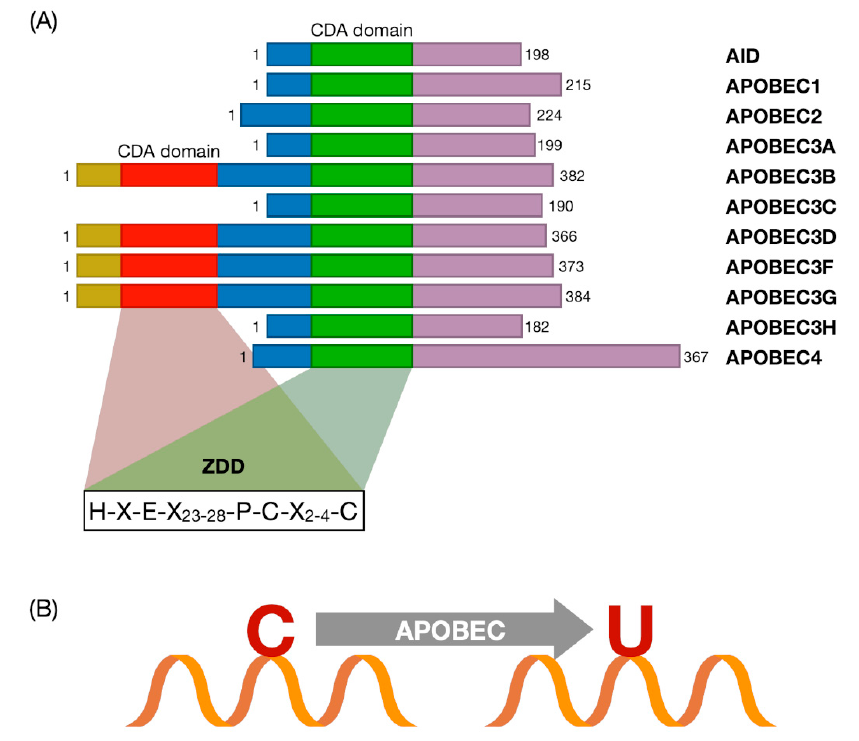
Figure 1. ( A ) Schematic representation of the apolipoprotein B mRNA editing enzyme catalytic polypeptide-like (APO- BEC) family genes. The diagram shows the structural organization of APOBEC family proteins. The domains and position of the evolutionarily conserved residues are shown. The red box represents the catalytically inactive cytidine deaminase (CDA) domain, while the green box is the catalytically active CDA domain. The zinc-dependent deaminase (ZDD) con- sensus amino acid sequence (H-X-E-X23-28-P-C-X2-4-C) is shown. X represents any amino acid. Histidine (H) and cysteine (C) residues bind zinc at the active site, the glutamic acid residue (E) controls proton shuttling through deamination. CDA: Catalytic site cytidine deaminase. ZDD: Zinc-dependent deaminase. (Modified from [39]) ( B ) Reaction of the ssDNA cy- tosine deamination catalyzed by APOBEC family